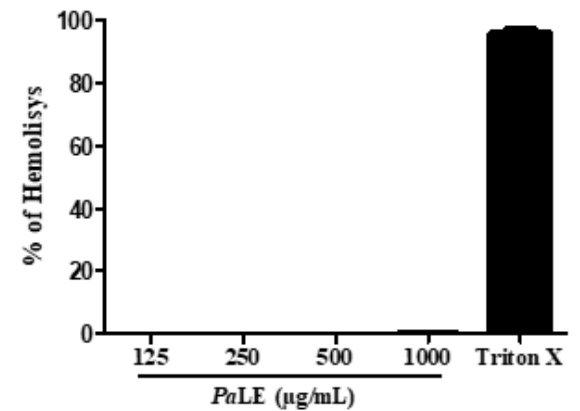
Figure 1. Evaluation of Pa LE hemolytic activity. The data are presented as mean ± standard deviation of three independent experiments.